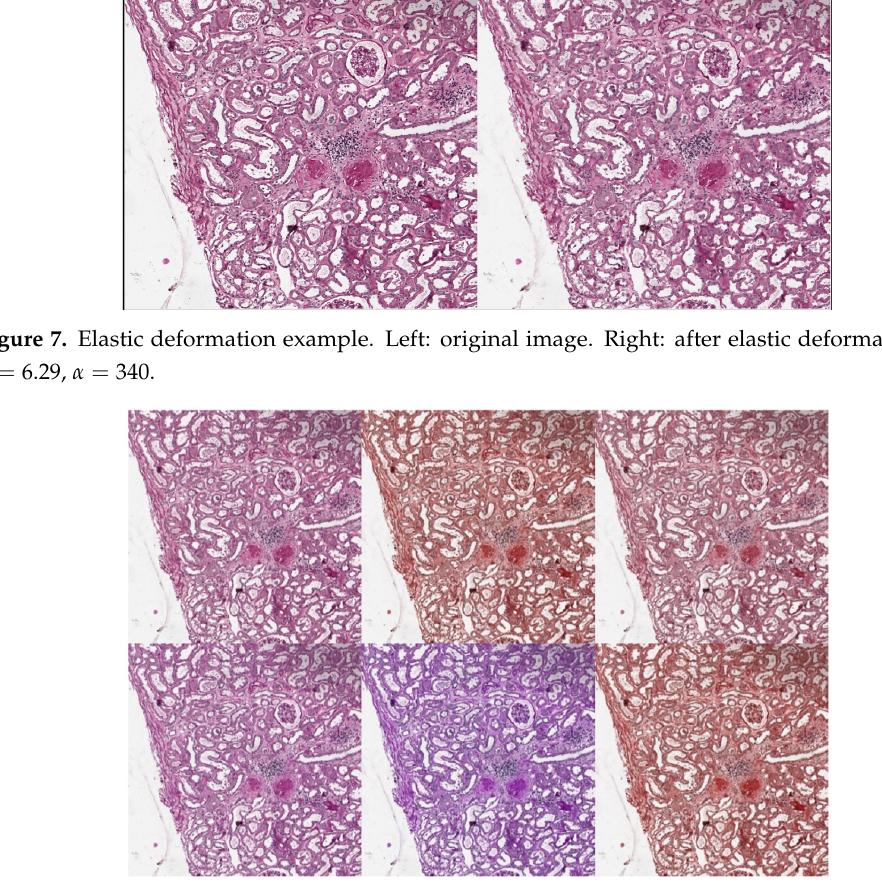
Figure 8. HSV shift examples. Top Left: original image. Top Center: ∆ H = + 0.18, ∆ S = + 0.03. Top Right: ∆ H = + 0.06, ∆ S = − 0.06. Bottom Left: ∆ H = − 0.04, ∆ S = − 0.02. Bottom Center: ∆ H = − 0.11, ∆ S = + 0.10. Bottom Right: ∆ H = + 0.18, ∆ S = +